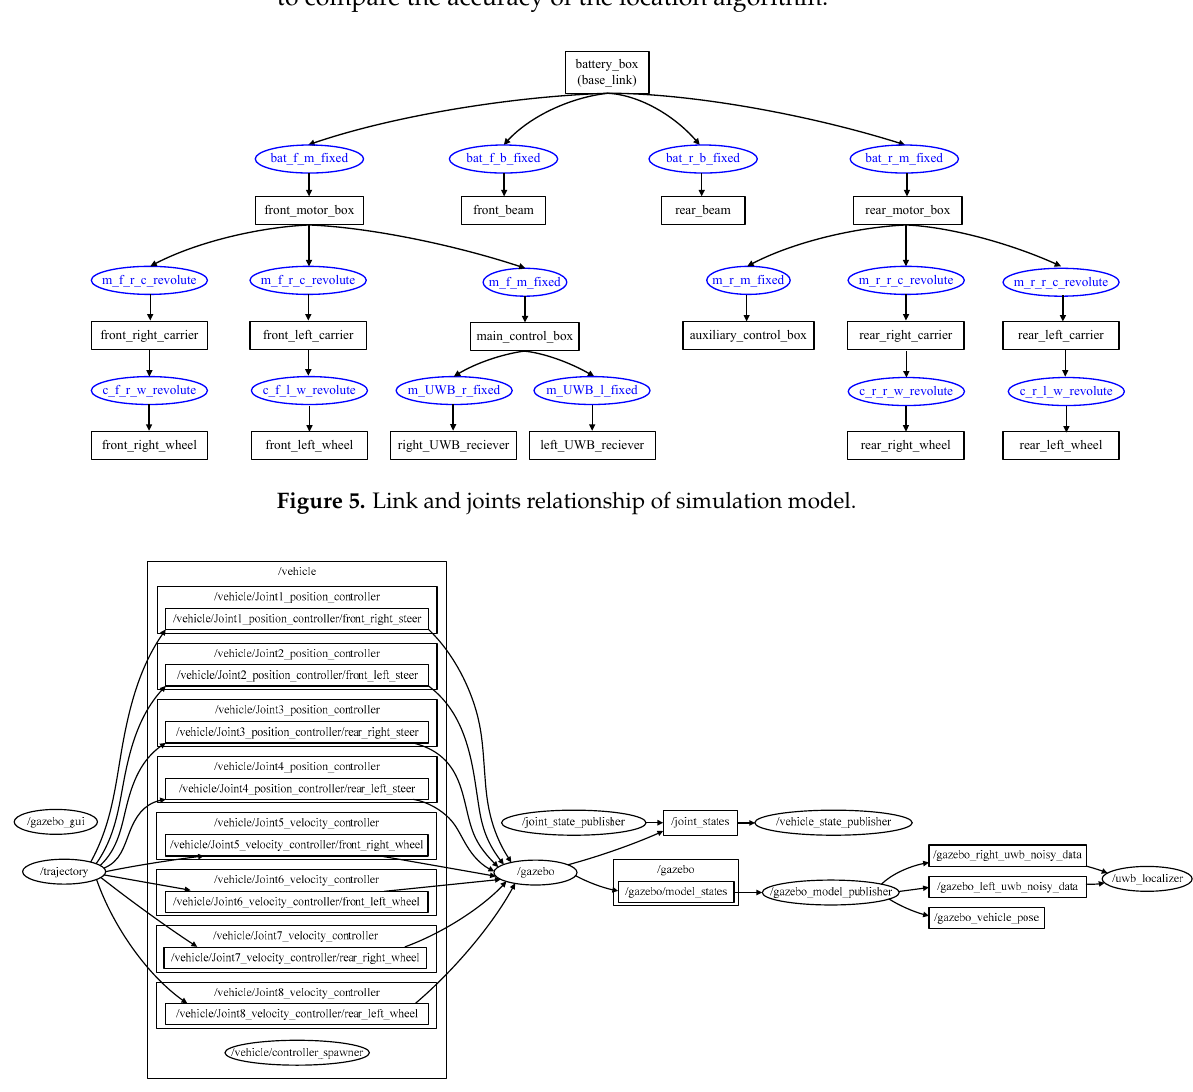
Figure 6. The topological relationship diagram of nodes and topics.